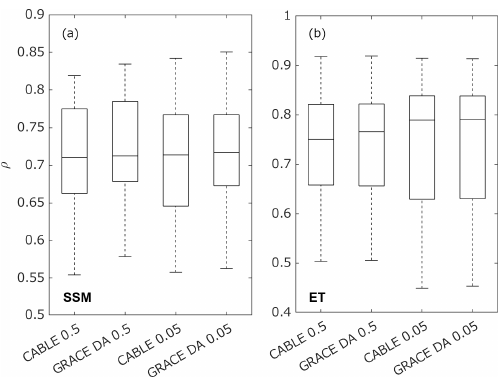
Figure 15. Box and whisker plots showing correlation values be- tween (a) simulation case studies and in situ surface soil moisture and between (b) simulations and evapotranspiration